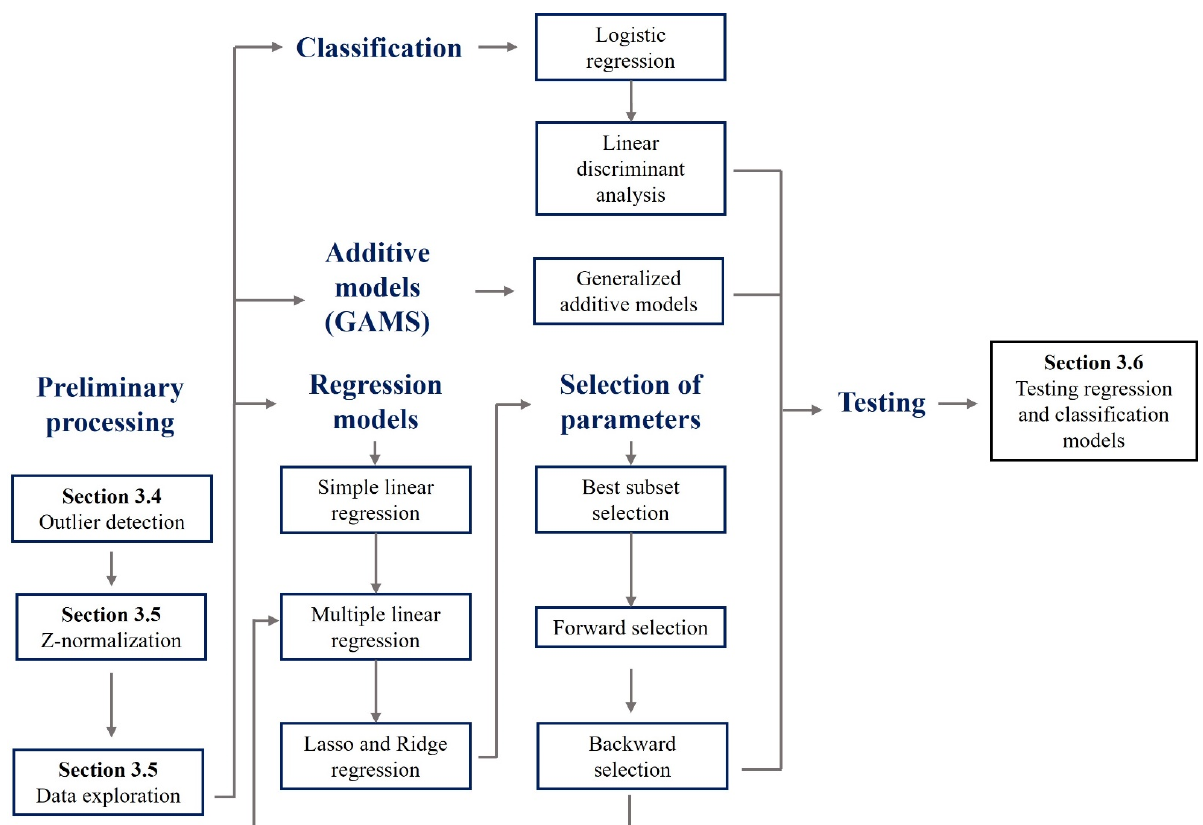
Figure 3. Training and testing of prediction models.